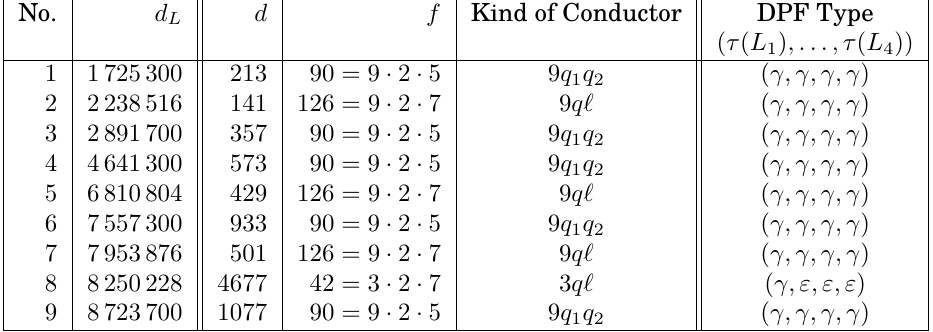
Table 17: Nine explicit ramified quartets in the range 0 < d L < 10 7 .